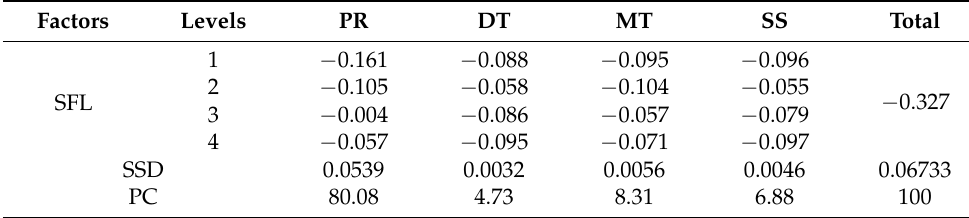
Table 12. The Taguchi-CRITIC-MOORA method for combined outputs: Pareto